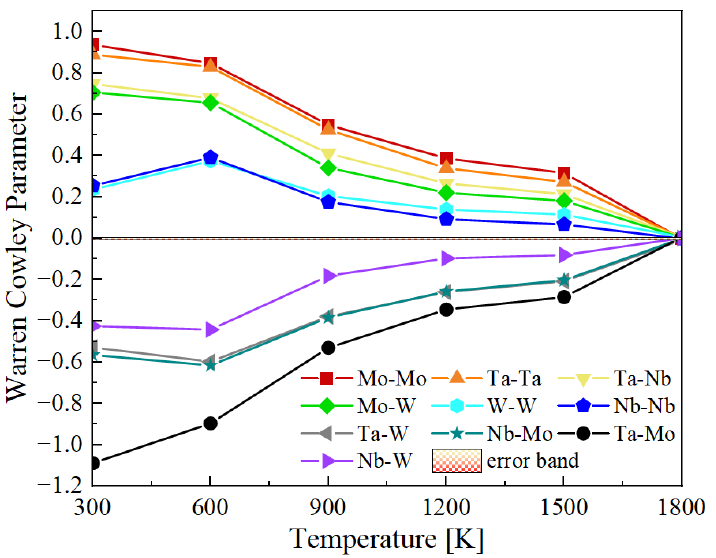
Figure 3. First-nearest neighbor Warren–Cowley parameter as a function of annealing